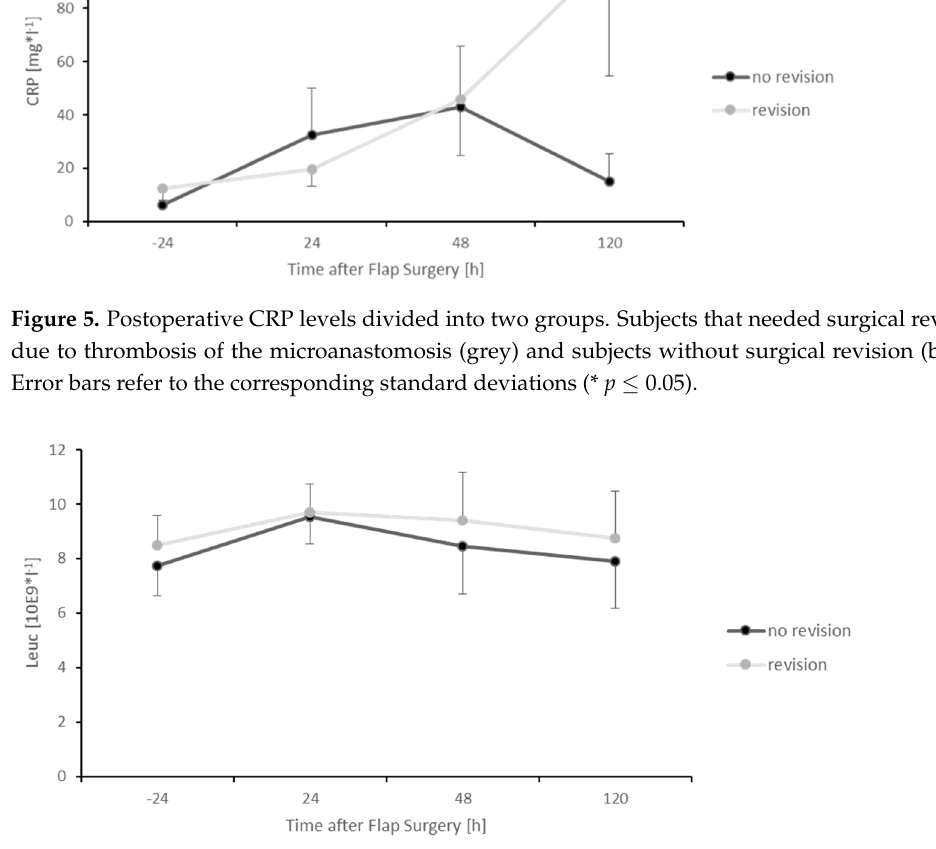
Figure 6. Postoperative levels of leukocytes divided into two groups. Subjects that needed surgical revision due to thrombosis of the microanastomosis (grey) and subjects without surgical revision (black). Error bars refer to the corresponding standard deviations (* p ≤ 0.05).